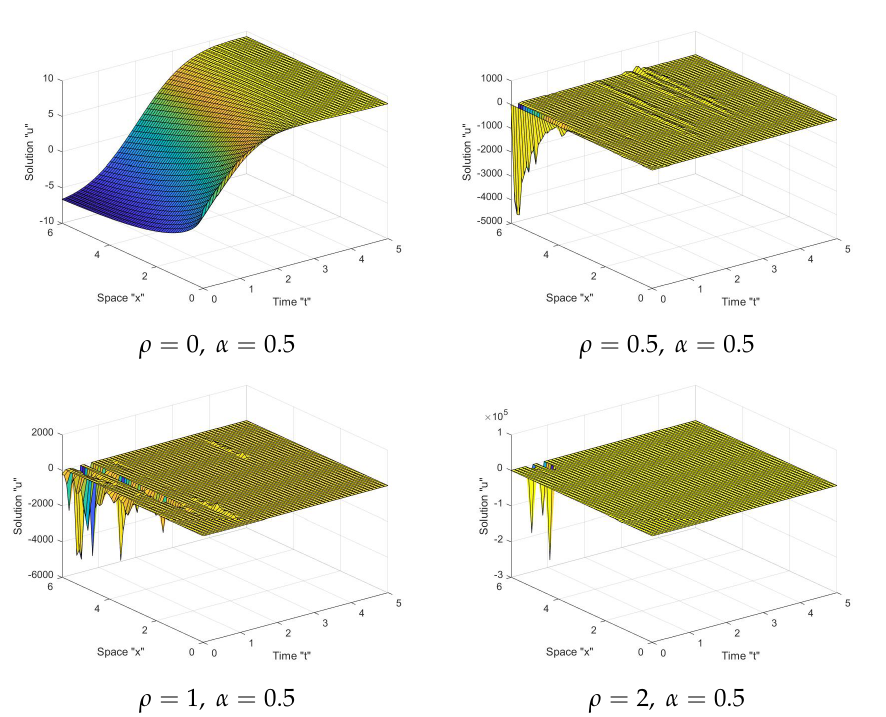
Figure 2. Graph of solution u 2 in Equation (21) with α =